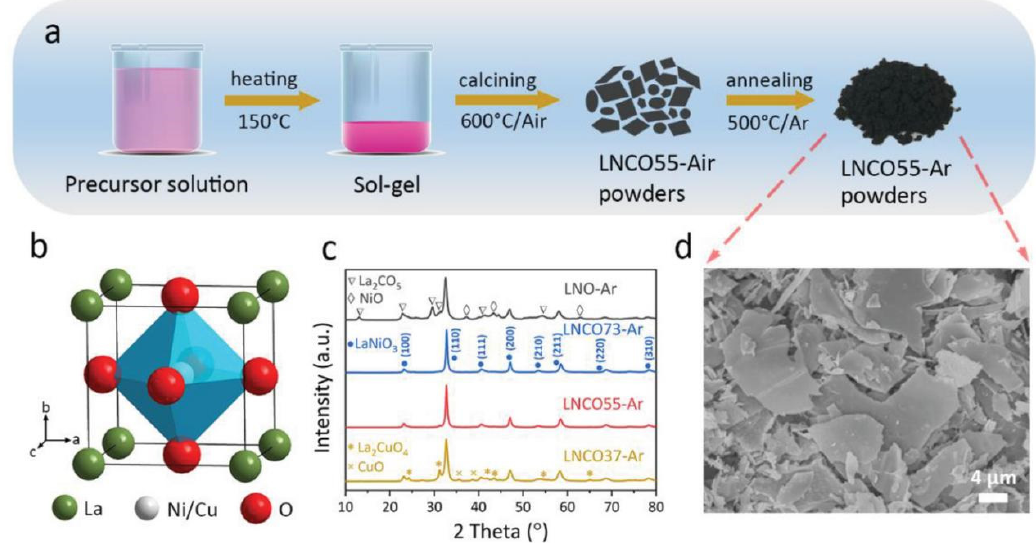
Figure 2. ( a ) Schematic diagram of LNCO55-Ar powders production process ( b ) Perovskite structure. ( c ) XRD patterns of synthesized LNO-Ar, LNCO73-Ar, LNCO55-Ar, and LNCO37-Ar. ( d ) SEM image of LNCO55-Ar [32].